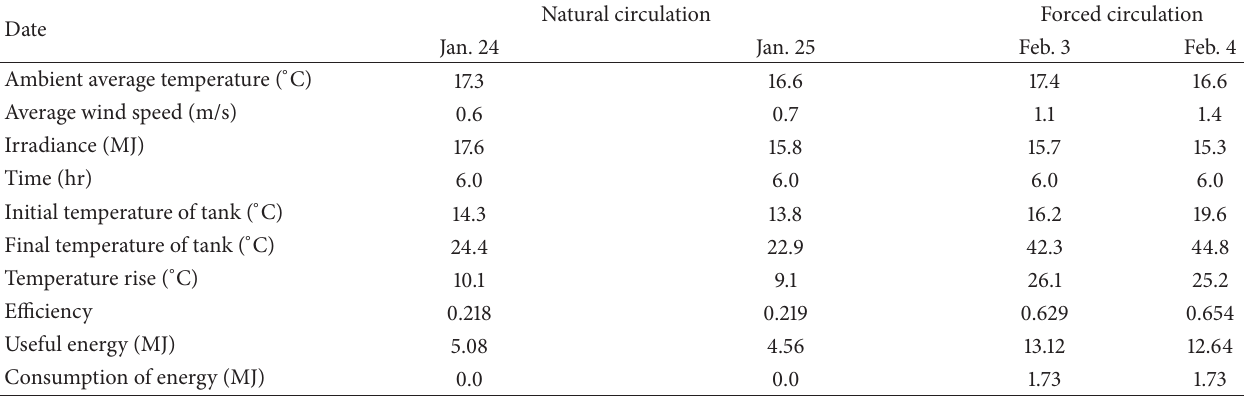
Table 5: Performance of solar water heater with flat-plate collector at a fixed surface slope angle of 90 ∘ under natural circulation and forced